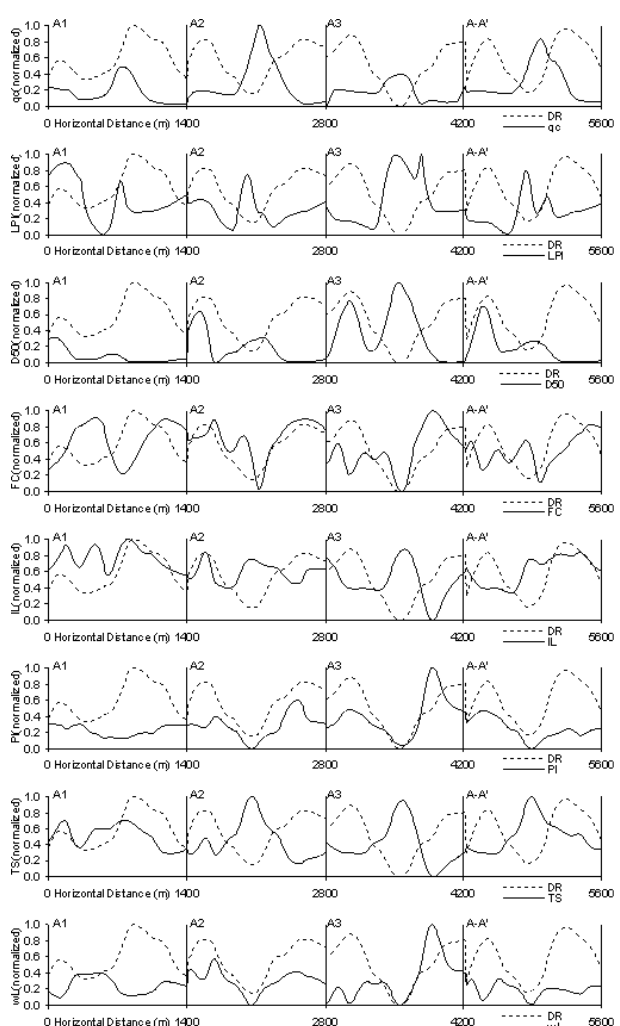
Fig. 5. Group A cross